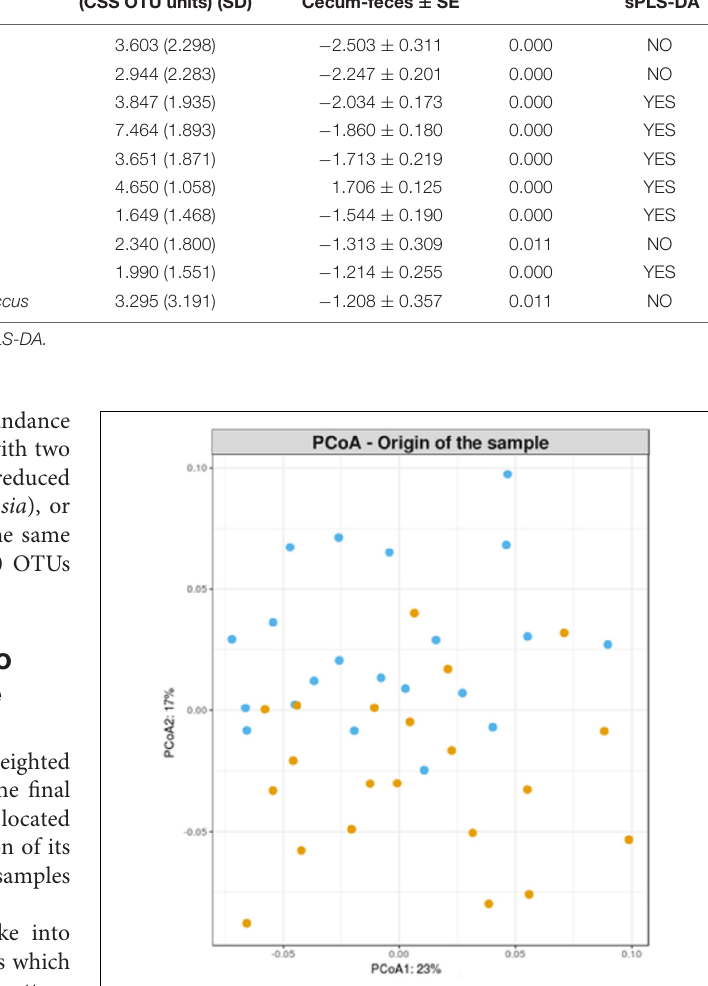
TABLE 6 | OTUs most differentially represented between fecal and cecal samples. OUT ID and taxonomical assignment